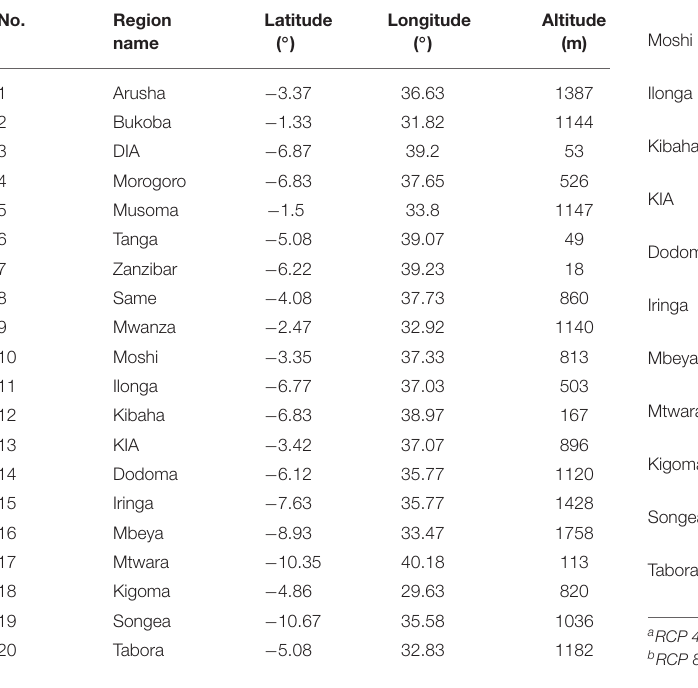
TABLE 2 | Information of the selected representative regions.